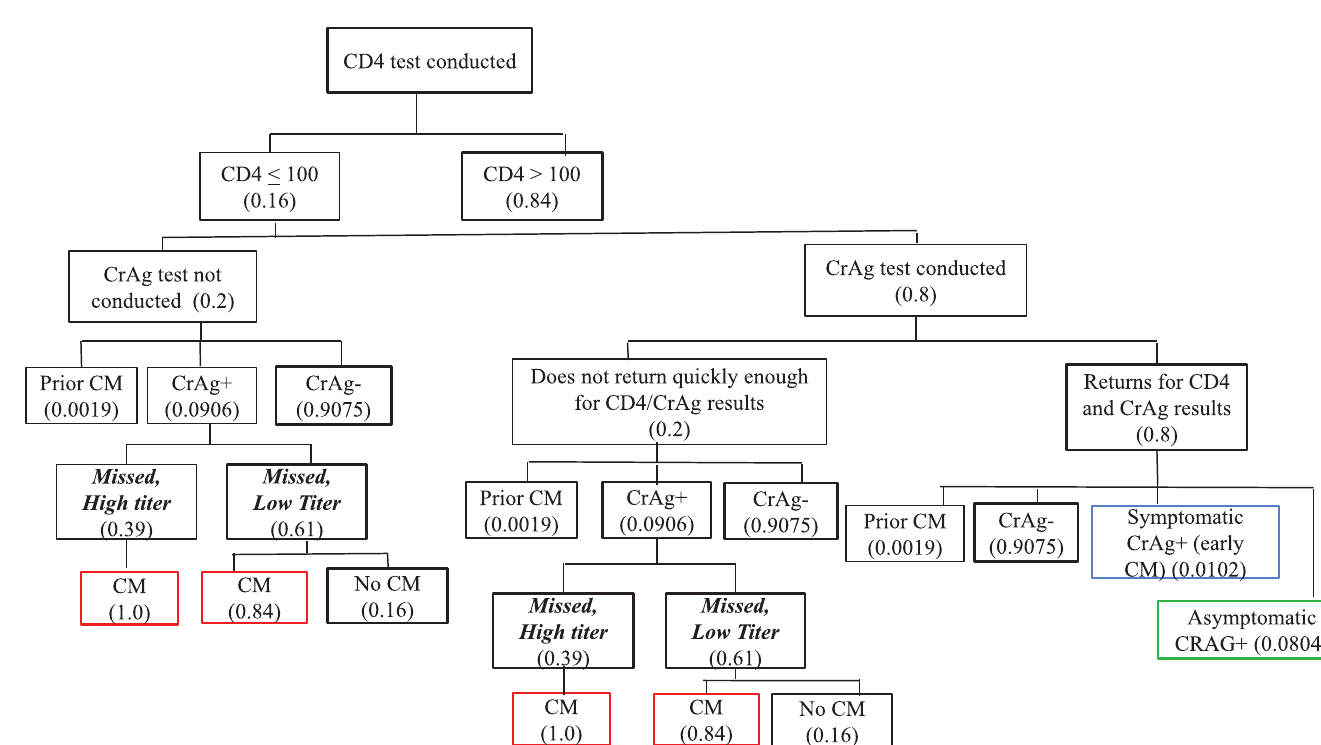
Fig 1. Base case model of CrAg screening reflexively for CD4 counts < 100 cells/ μ L.